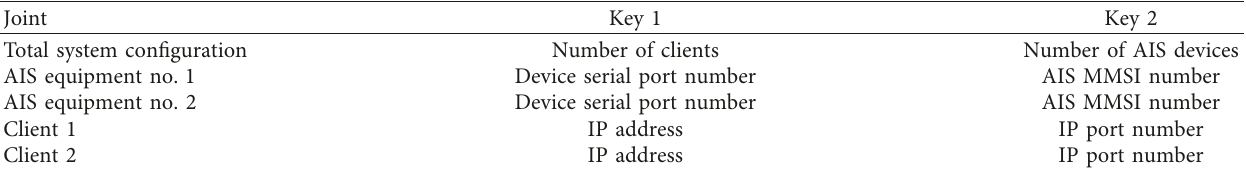
Table 3: Dual-machine dual-client system INI configuration file.